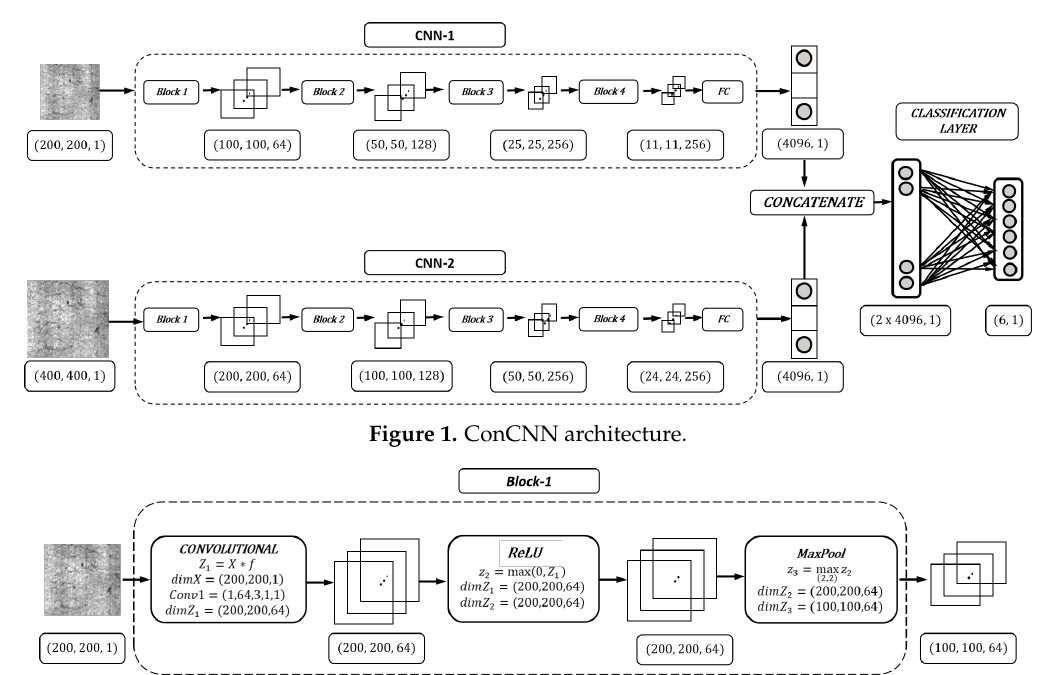
Figure 2. The detailed structure of a